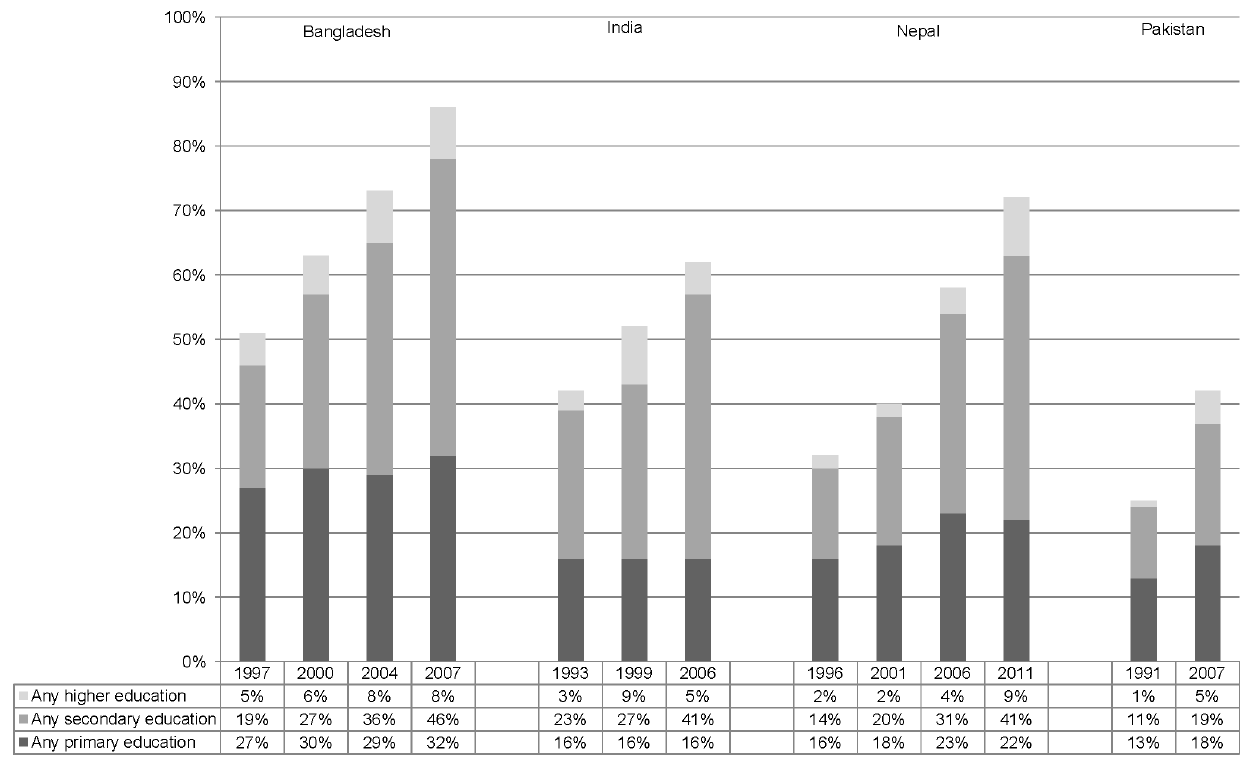
Figure 1. Education levels of ever married 20–24 year old women in Bangladesh, India, Nepal, and Pakistan, 1991–2011.